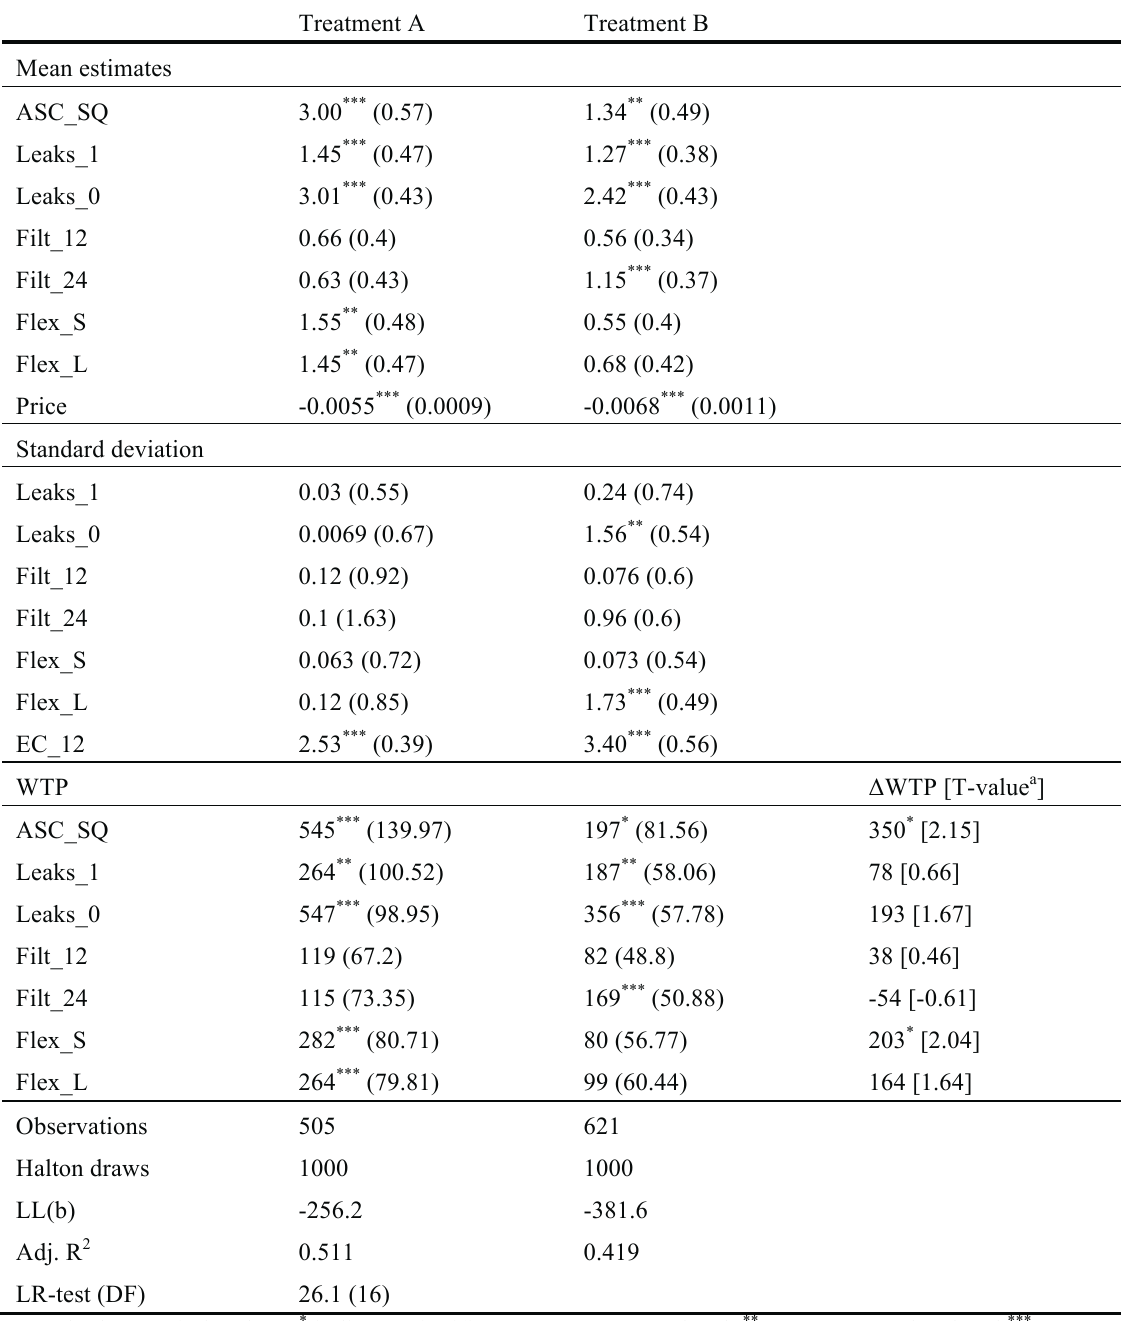
Table 4: Preference models (dependent variable: Choice of ostomy pouch) Treatment A Treatment